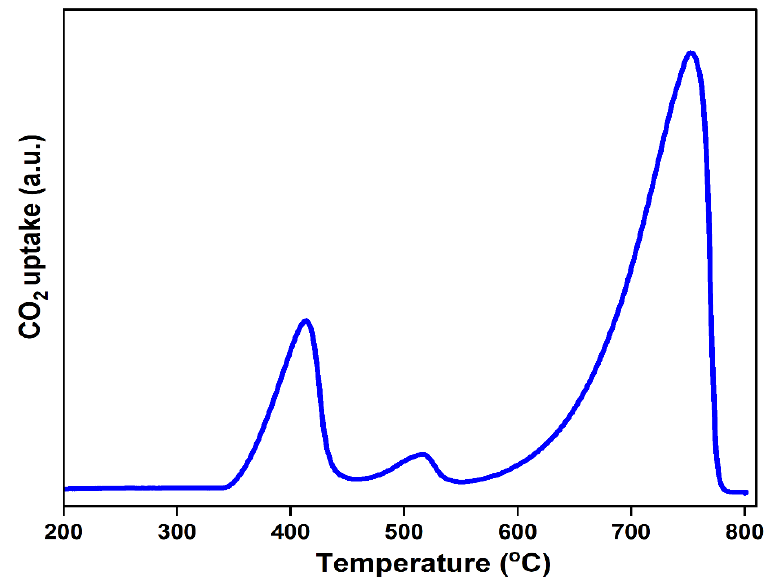
Figure 4. CO 2 − TPD profile of CaO − ZrO 2